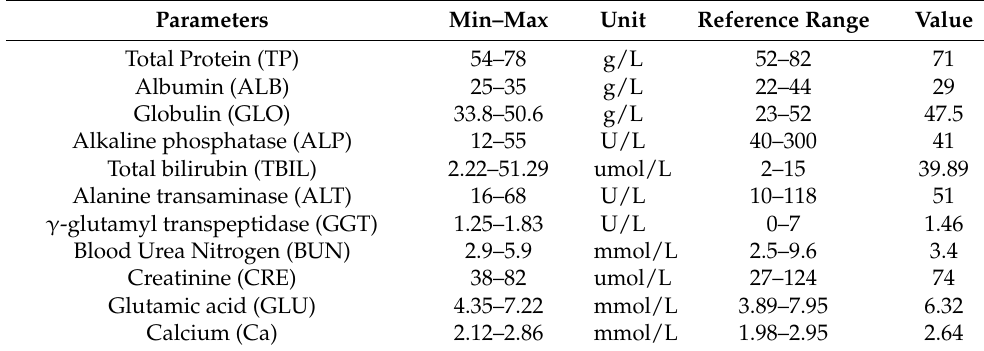
Table 3. Results of Blood Biochemical Examination.